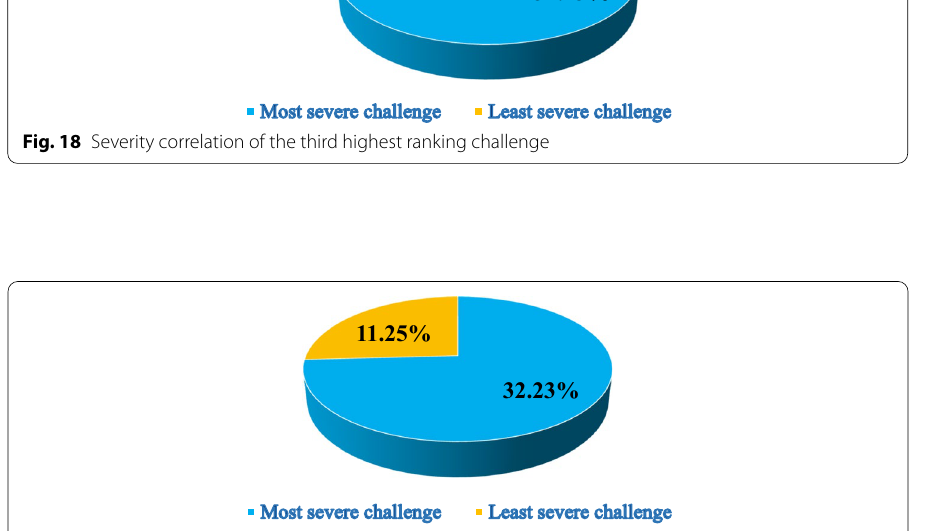
Fig. 19 Severity correlation of the fourth highest ranking